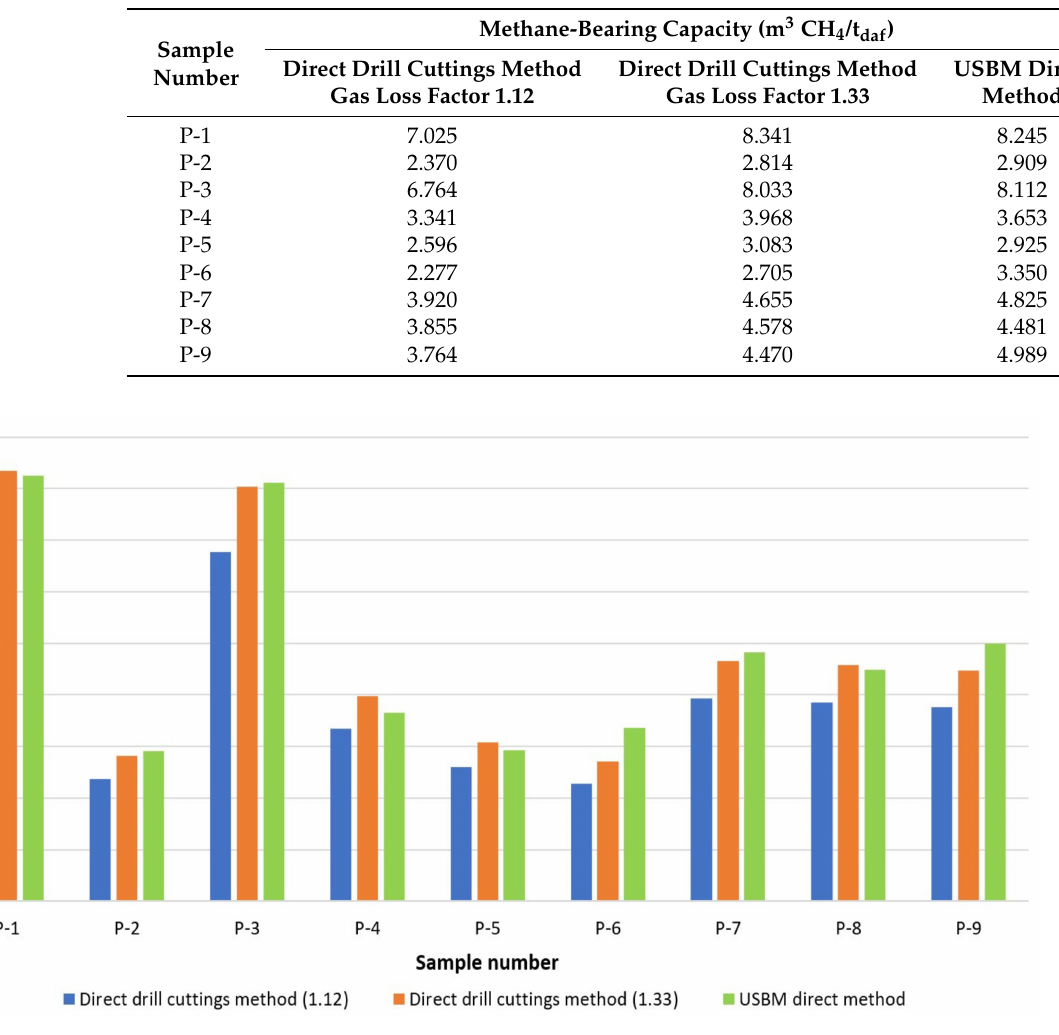
Table 3. Comparison of methane-bearing capacity test results obtained using the USBM method and the direct drill cuttings method with a loss factor of 1.12 and 1.33.